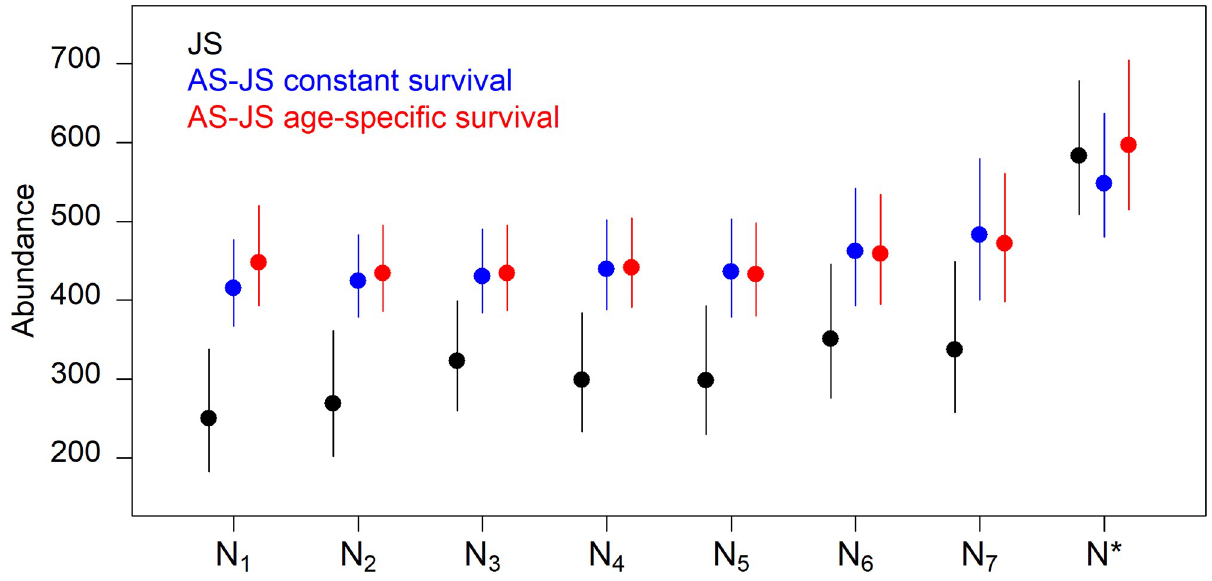
Fig 4. Annual and superpopulation abundances for western Hudson Bay (WHB) polar bears from Jolly-Seber models that ignore age structure (black) or incorporate age structure and assume annual survival is constant (blue) or a quadratic function of age (red). Points and error bars are posterior medians and 95% credible intervals, respectively. Analyses used a subset of the larger, long-term WHB polar bear study and, therefore, do not reflect the status of the entire subpopulation ([28]; see Methods for additional details).